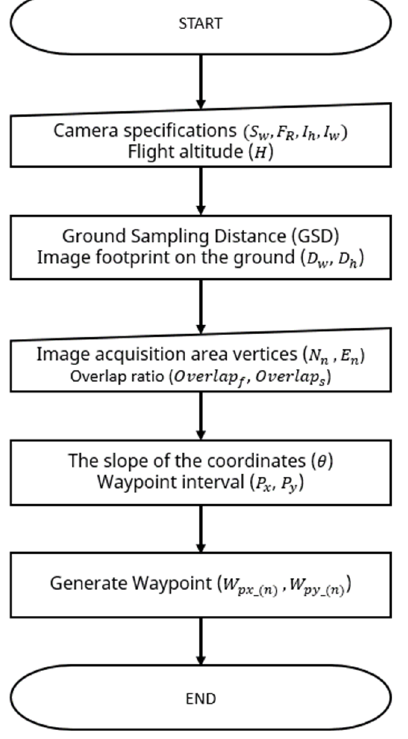
Figure 3. Variables to consider when generating a path: ( a ) an example of the overall path; ( b ) vertex of the area to be captured; ( c ) correlation of camera capture.